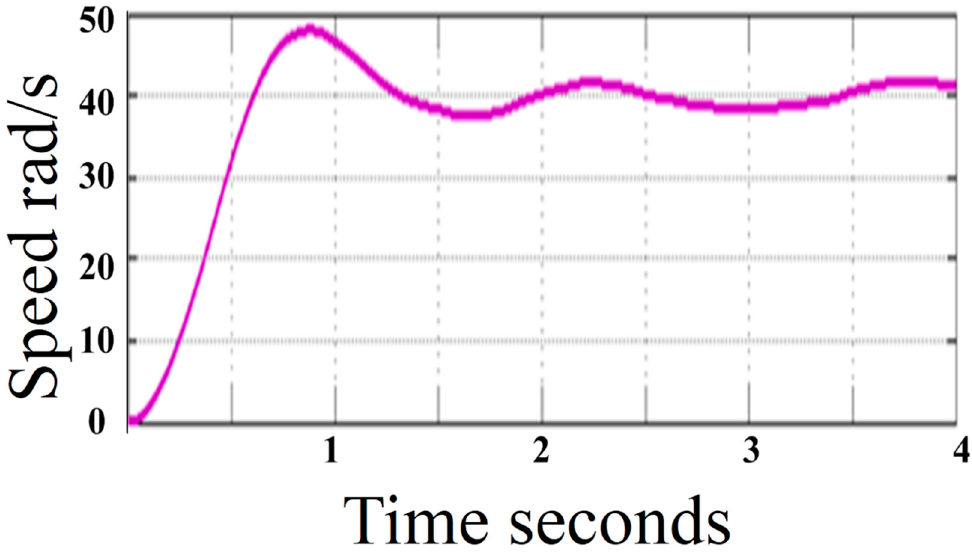
Figure 15. Simulation of the best result for ST2FDE with noise 0.9 FLC.